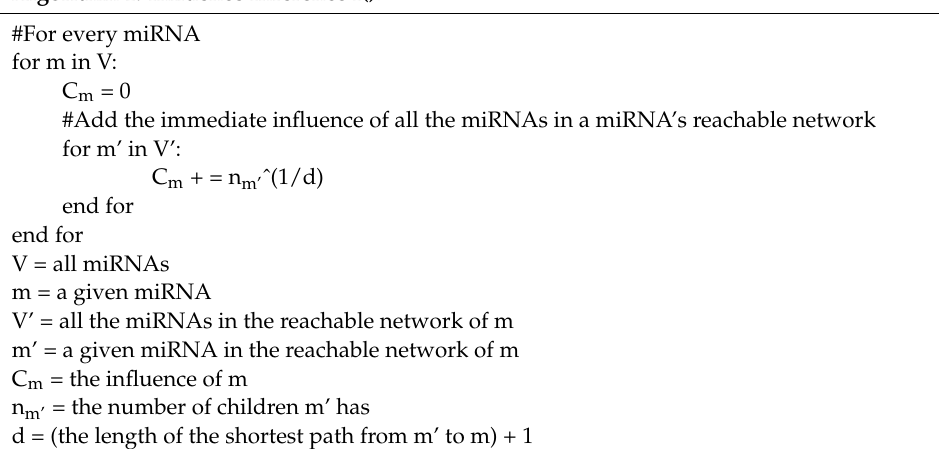
Algorithm 1: Influence Inference I() .